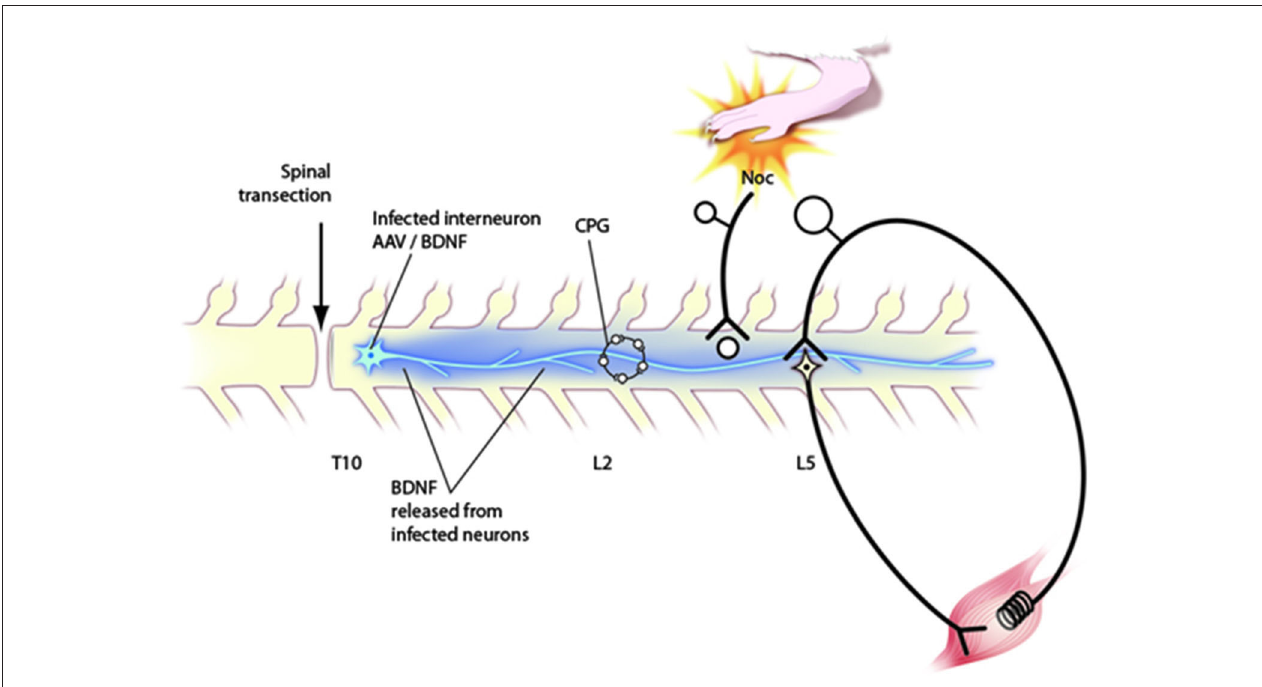
that such injections affect the CPG in upper lumbar segments, nociceptive processing in the dorsal horn and the stretch reflex pathway. Further discussion of these effects in the